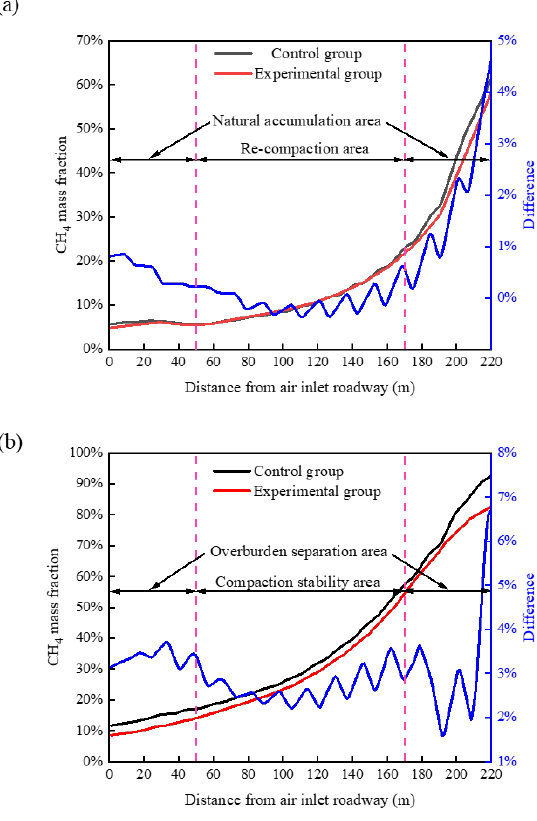
Figure 15. Comparison of gas mass fraction in the inclined direction between the experimental group and the control group for ( a ) caving zone and ( b ) fracture